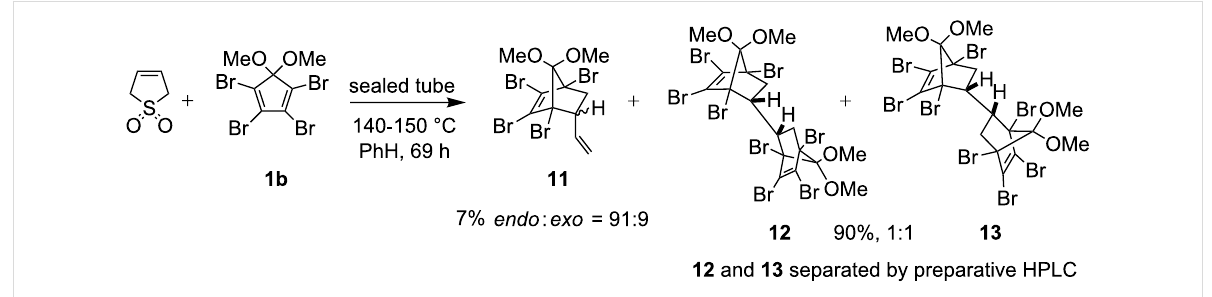
Scheme 4: Diels–Alder reaction of 1b with 3-sulfolene.